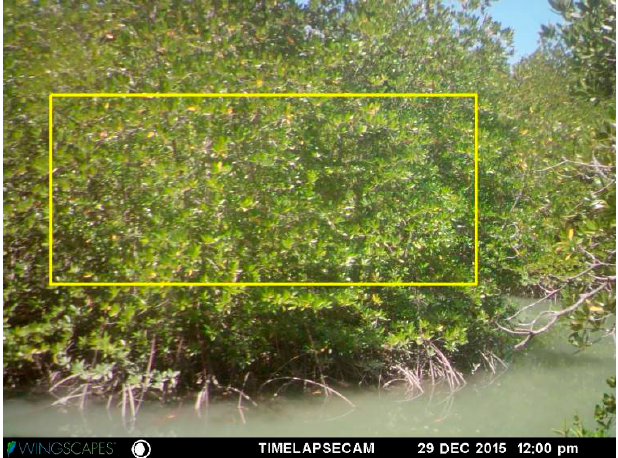
Figure 2. Field of view of the camera with the yellow square used as a Region of Interest (ROI, 801 × 1801 pixels). The ROI was selected for visual interpretation of the square ROI [92], which was covered with the dominant mangrove species [90], Rhizophora apiculata.